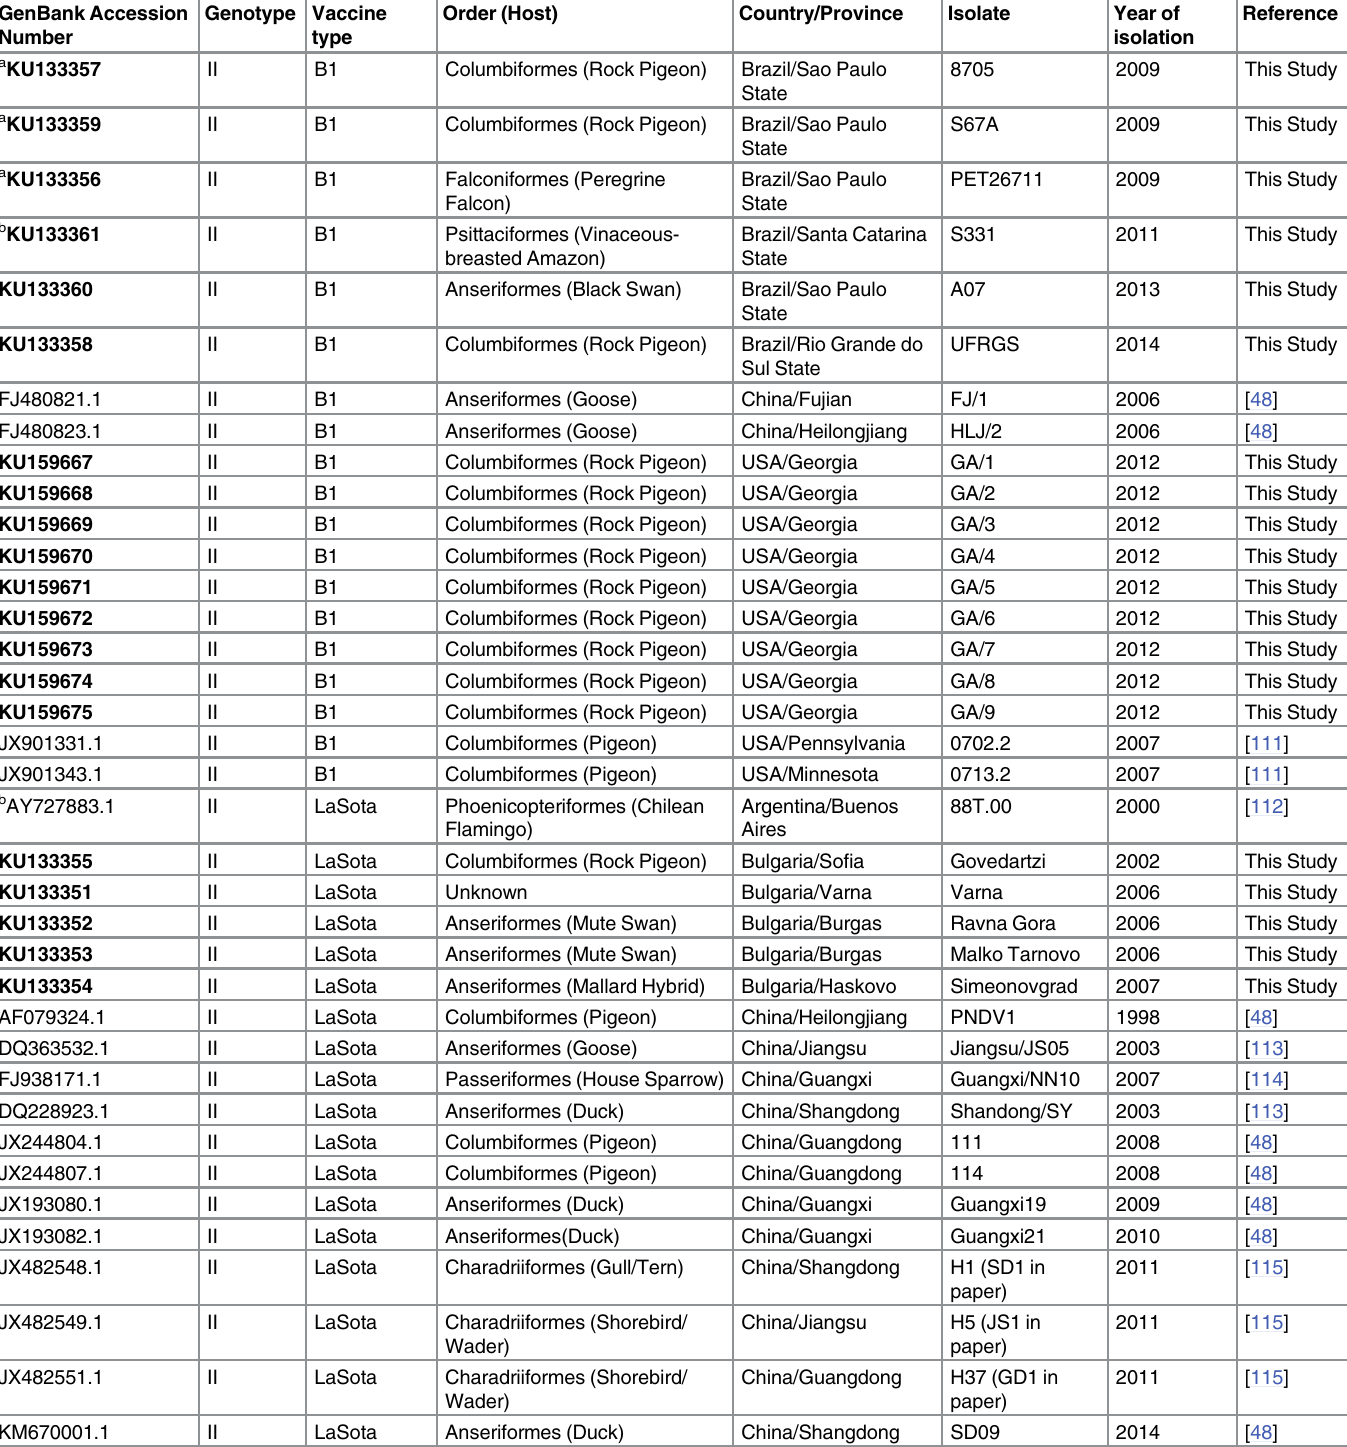
Table 1. Collated Isolates from GenBank and SEPRL samples. A total of 54 isolates from the following taxonomic orders are tabulated below: Accipitri- formes (n = 1); Anseriformes (n = 13); Charadriiformes (n = 3); Columbiformes (n = 23); Falconiformes (n = 1); Galliformes (n = 4); Passeriformes (n = 2); Pele- caniformes (n = 1); Phoenicopteriformes (n = 1); Psittaciformes (n = 4); Unknown (n = 1). GenBank accession numbers bolded are strains sequenced from this